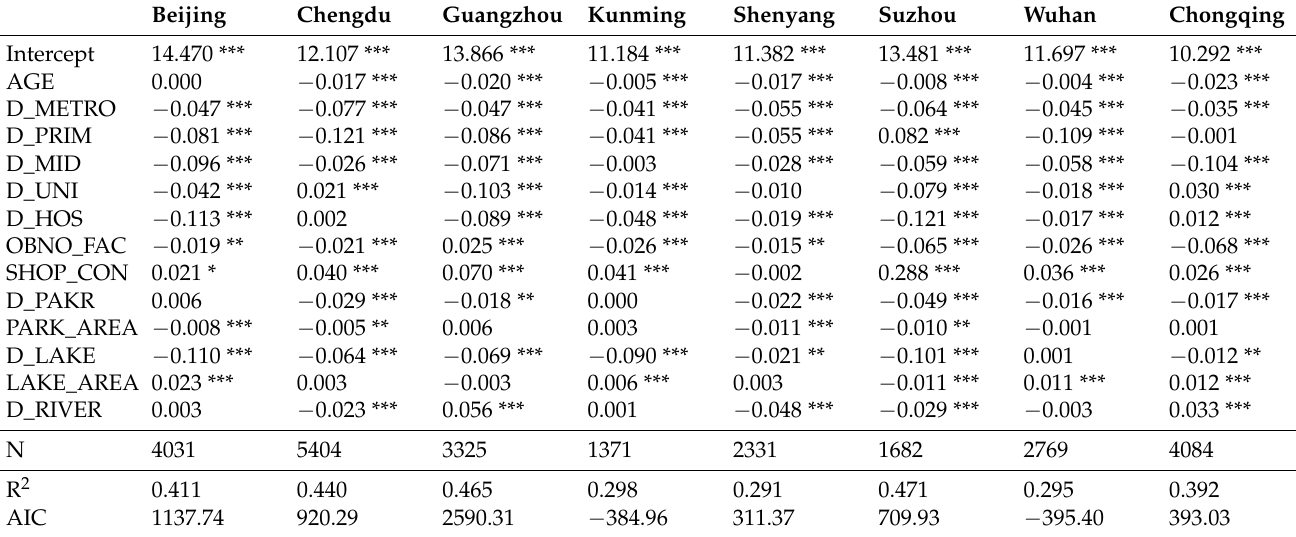
Table A9. OLS estimation results for Model